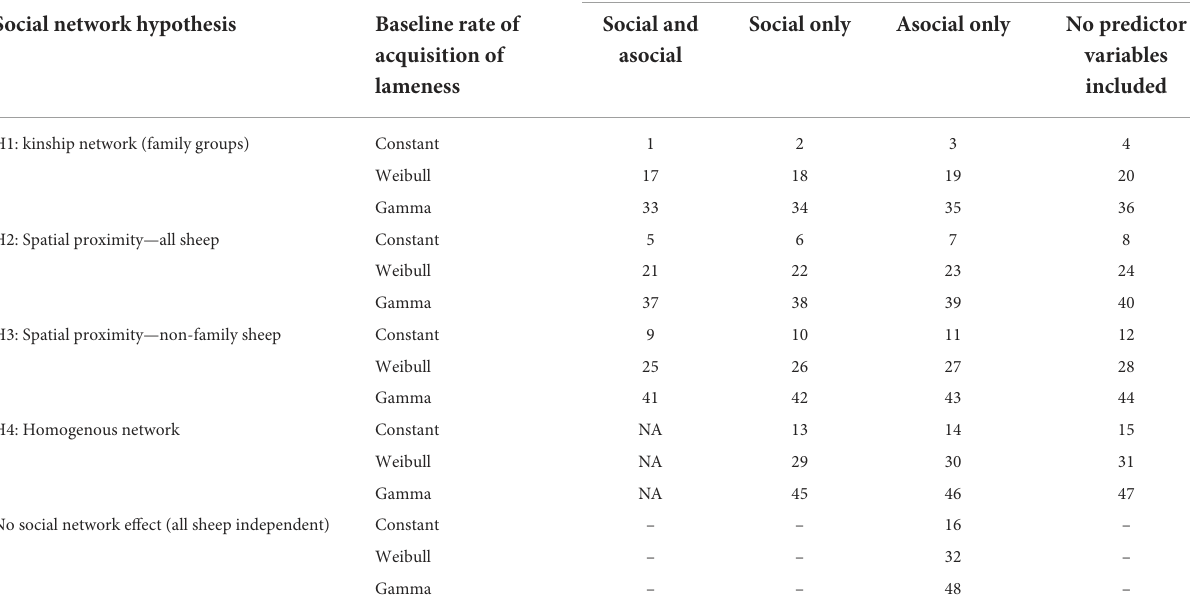
TABLE 1 Reference table for each model with the combination of individual-level variables and baseline rates of acquisition of lameness. Social network hypothesis Baseline rate of